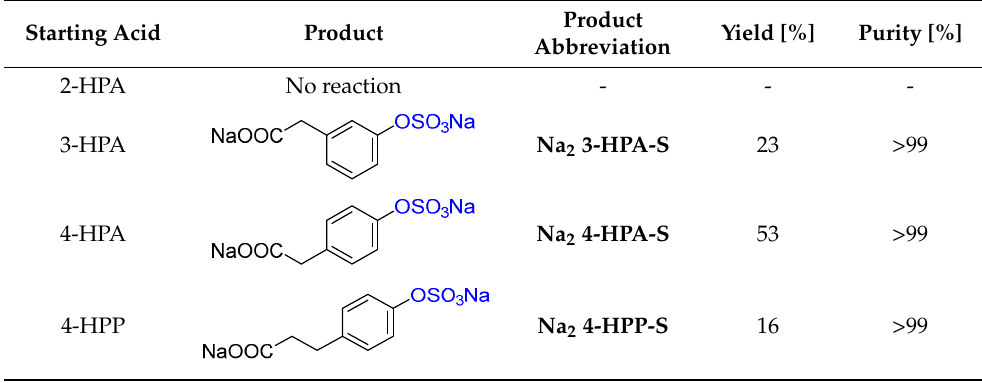
Table 2. Chemical sulfation using SO 3 ·pyridine via a tributylammonium intermediate. Starting Acid